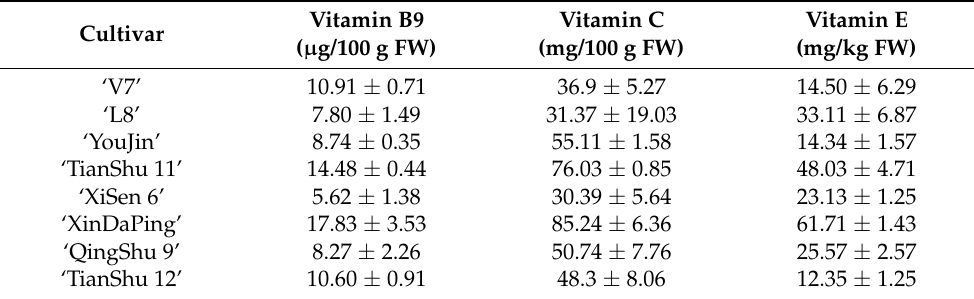
Table 6. Profiles of vitB9, vitC, and vitE among tubers of steamed potato cultivars on a fresh- weight